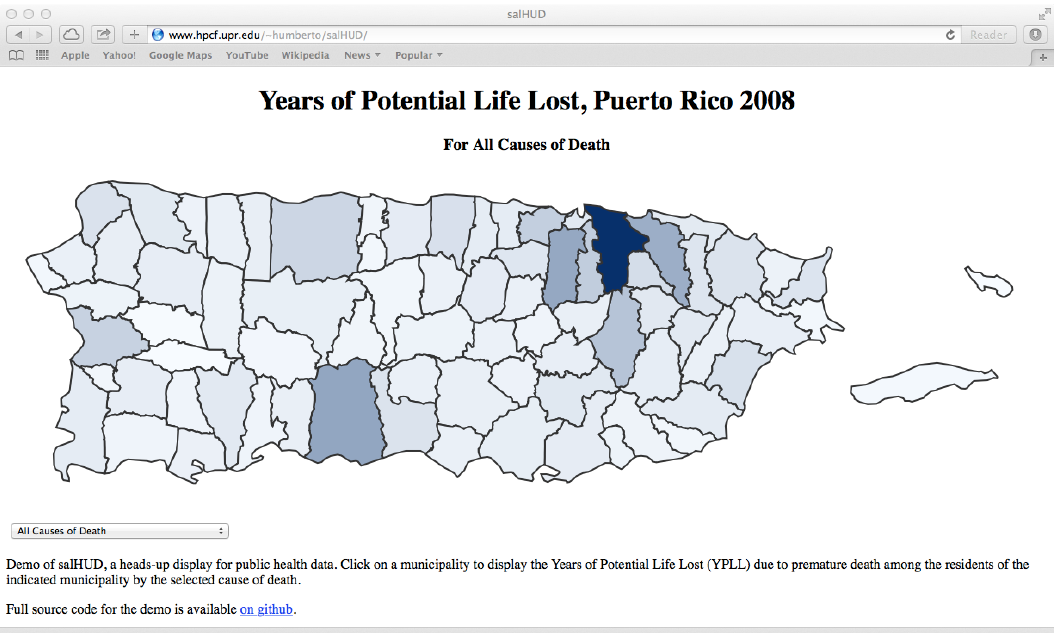
Figure 2. Screenshot of the SalHUD demo application shaded by all causes years of potential life lost (YPLL) in each municipality in Puerto Rico.